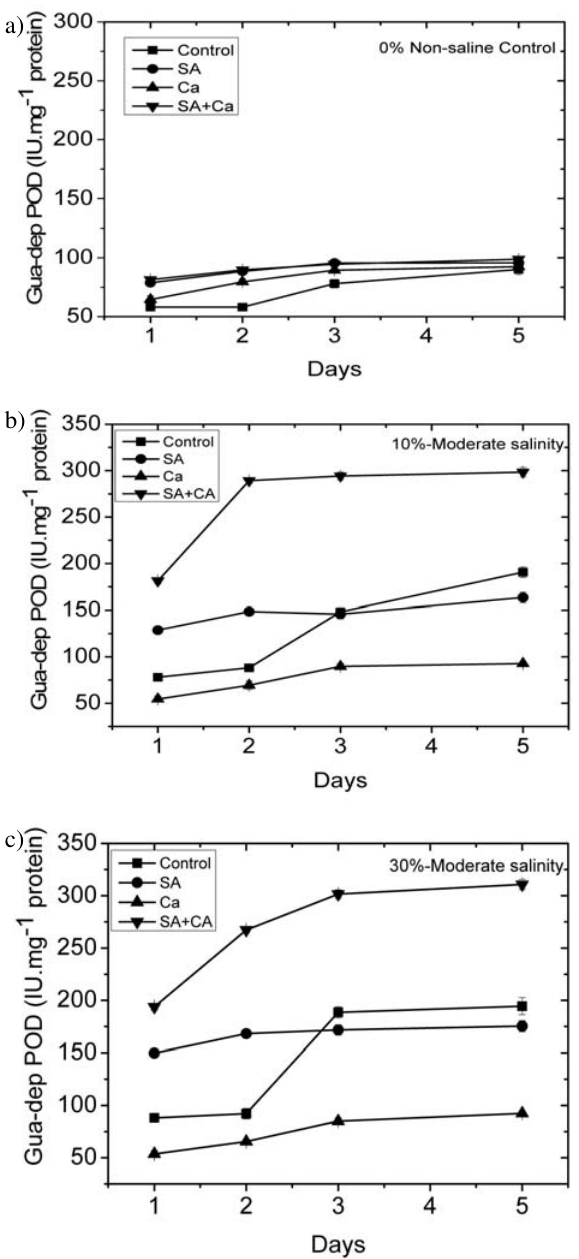
Figure 2. Activity of Gua-dep POD activities in seedlings of wheat under three different stres conditions a) Non-saline b) 10%-Mode- rate salinity and c) 30%-High salinity: with four traetments (- (cid:2) -), control; (- (cid:3) -), 0.5 mM SA; (- (cid:2) -), 50 mM Ca +2 ; (- (cid:3) -), 0.5 mM SA+50 mM Ca